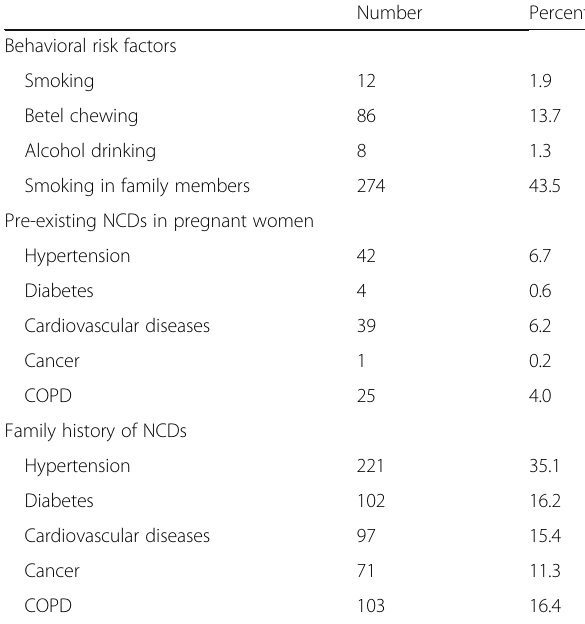
Table 2 Medical history of pregnant women ( n = 630)